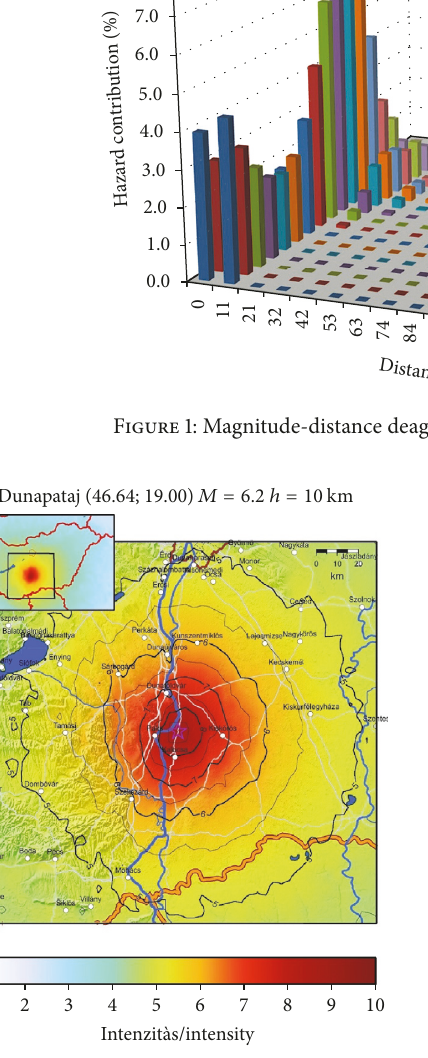
Figure 2: Instrumental intensity map of the Scenario 1